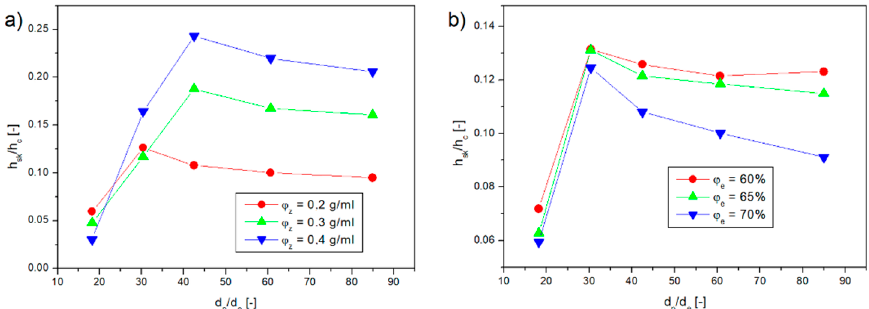
Figure 13. Dependence of dimensionless sediment height on dimensionless diameter: ( a ) for different concentrations of solid particles and ( b ) for different concentrations of the emulsion internal phase.